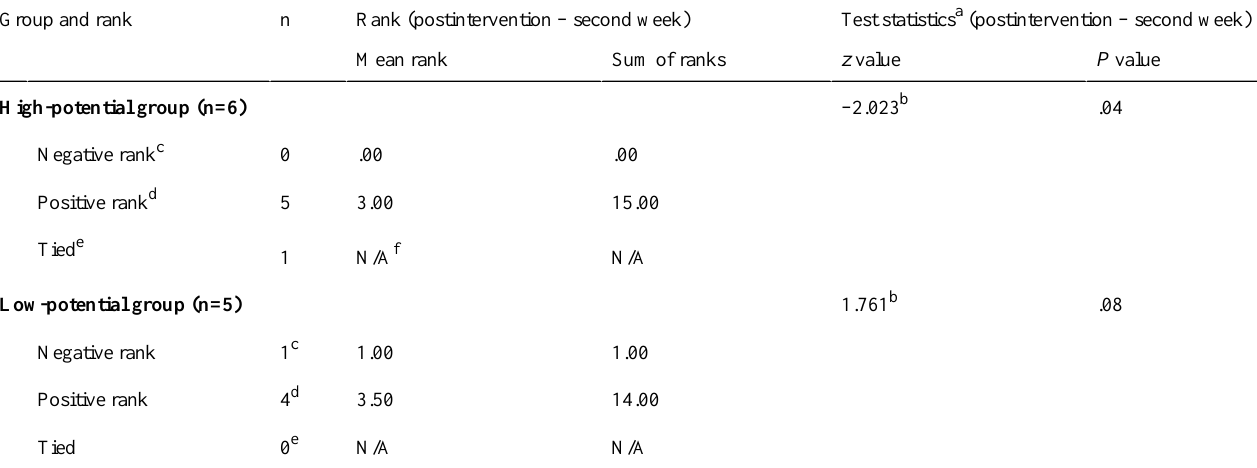
Table 5. Ranks and test statistics for the Computer Self-Efficacy Scale (mCSES) scores from the second-week and postintervention surveys for the high-potential and low-potential groups